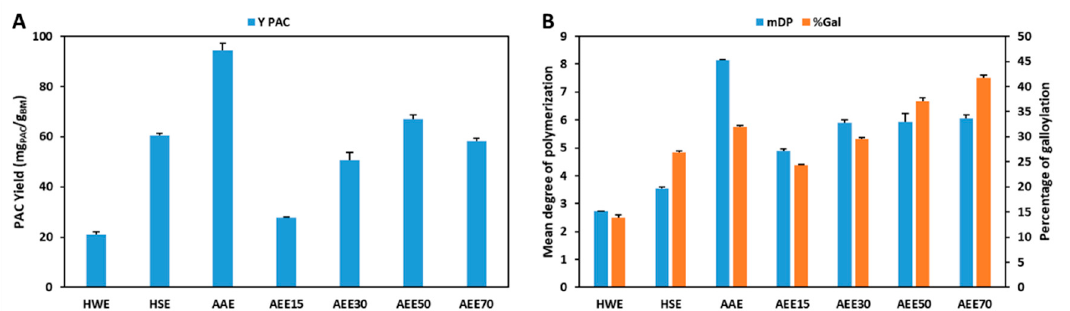
Figure 2. Comparison of Y PAC ( A ) and mDP and %Gal ( B ) obtained with conventional solvents (HWE—hot water extraction; HSE—hot sulfite extraction; AAE—aqueous acetone extraction; AEEx—aqueous ethanol extraction).